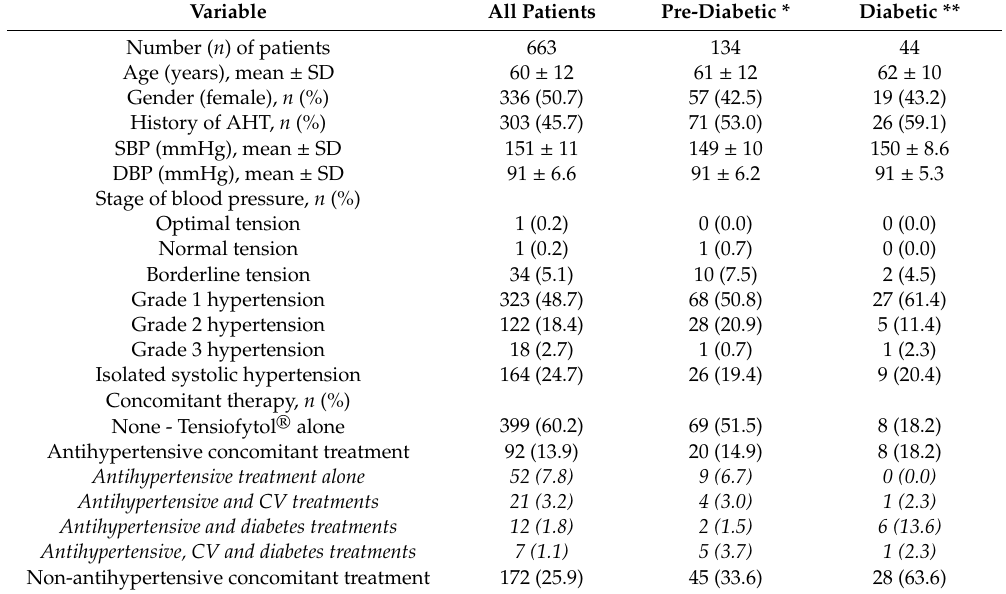
Table 2. Baseline characteristics of patients of the total population, pre-diabetic and diabetic